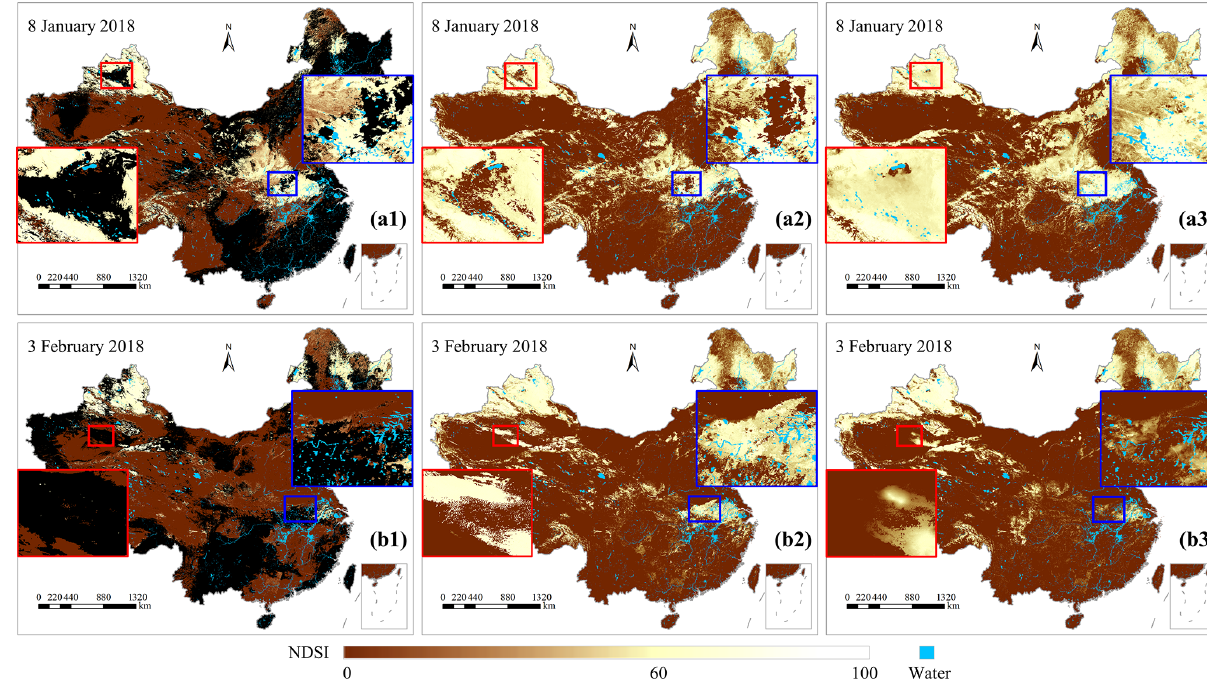
Figure 5. Comparison of TAC NDSI (column 1), MODIS CGF NDSI (column 2), and STAR NDSI (column 3) products on 8 January 2018 (group a) and 3 February 2018 (group b).